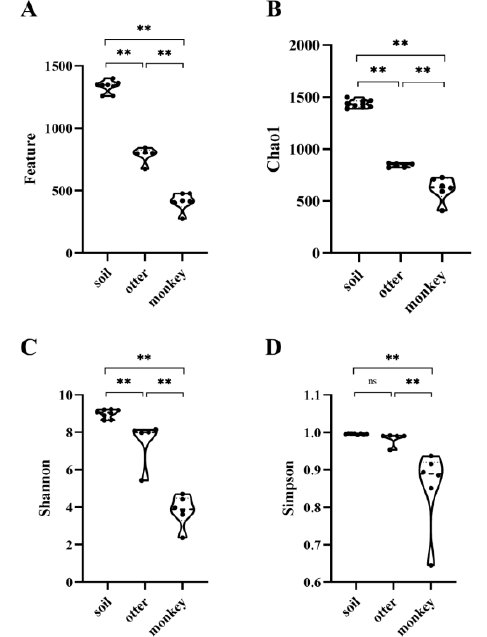
Figure 4. Alpha diversity, including the feature ( A ), Chao1 ( B ), Shannon ( C ), and Simpson ( D ) indices, between the habitat soil microbiome and fecal microbiomes of Eurasian otters and golden snub-nosed monkeys. ** p < 0.01.